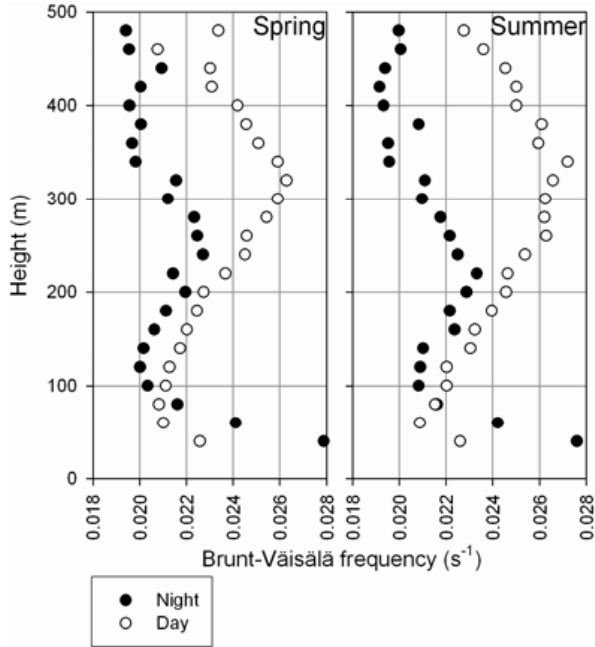
Fig. 3. BV profiles during day and night in the two most representa- Figure 3.- BV profiles during day and night in the two most representative seasons of tive seasons of the year. Average interquartile range was 0.015s − 1 during the night and 0.017s − 1 during the the year. Average interquartile range was 0.015 s -1 during the night and 0.017 s -1 during the day.